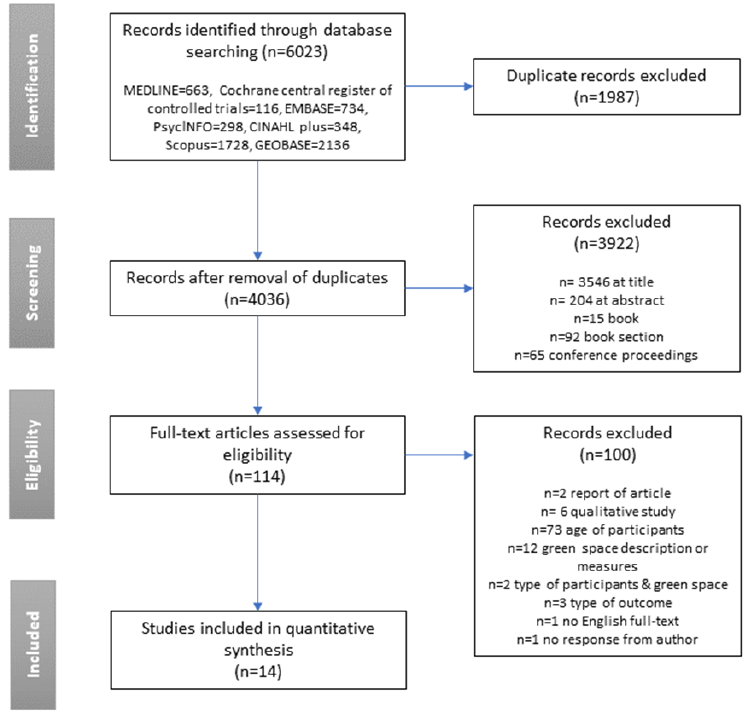
Figure 1. Article selection process.